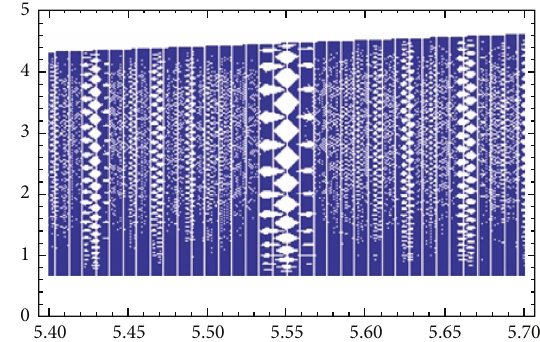
Figure 3: A bifurcation diagram in the (𝑎,𝑥) -plane for 𝑥 −1 = 1.2 and 𝑥 0 = 1.0 with parameter 𝑎 in the range from 5.4 to 5.7 . The plot is produced by Dynamica 3